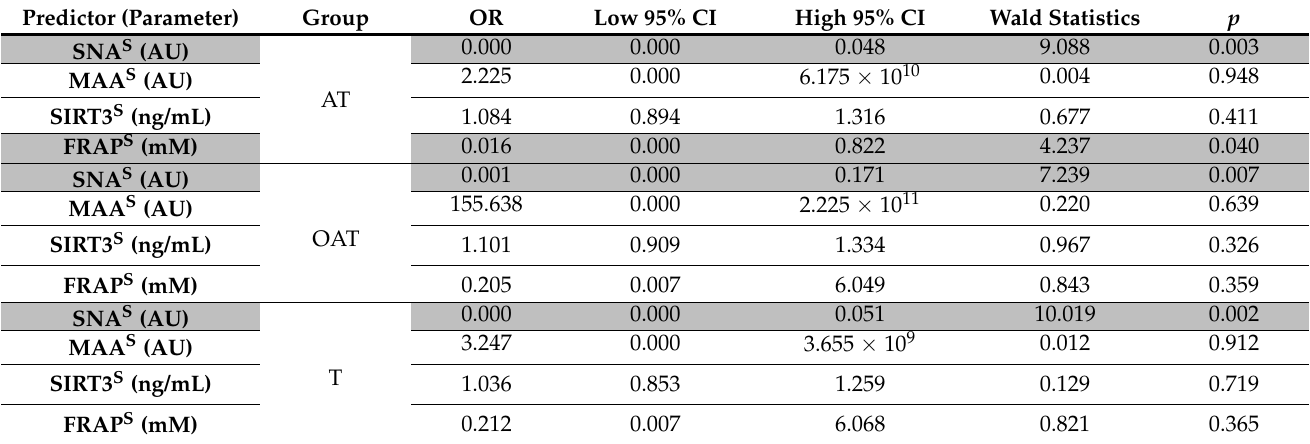
Table 5. The results of multinomial logistic regression analysis of selected serum